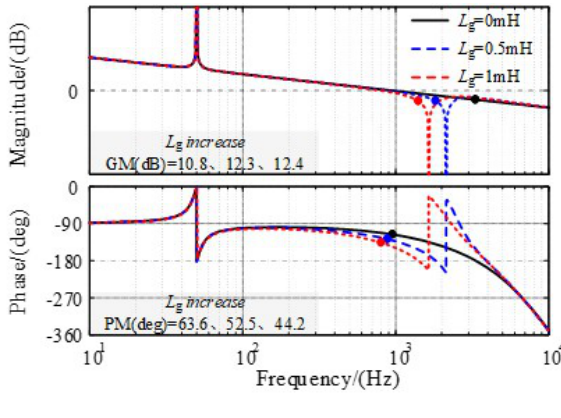
Fig. 3. Bode diagram of T WAC0 ( s ) . of the filter capacitor branch in parallel, and the equivalent circuit model is shown in Fig. 5(b).